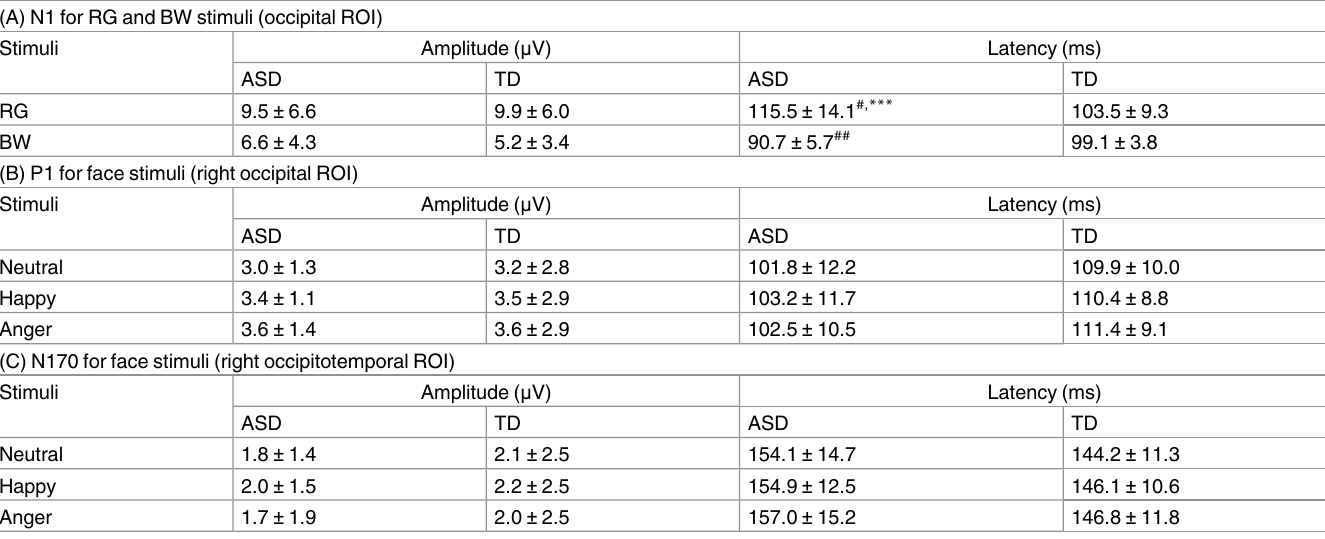
Table 2. VEPs for RG, BW, and face stimuli in ASD and TD adults. (A) N1 for RG and BW stimuli (occipital ROI) Stimuli